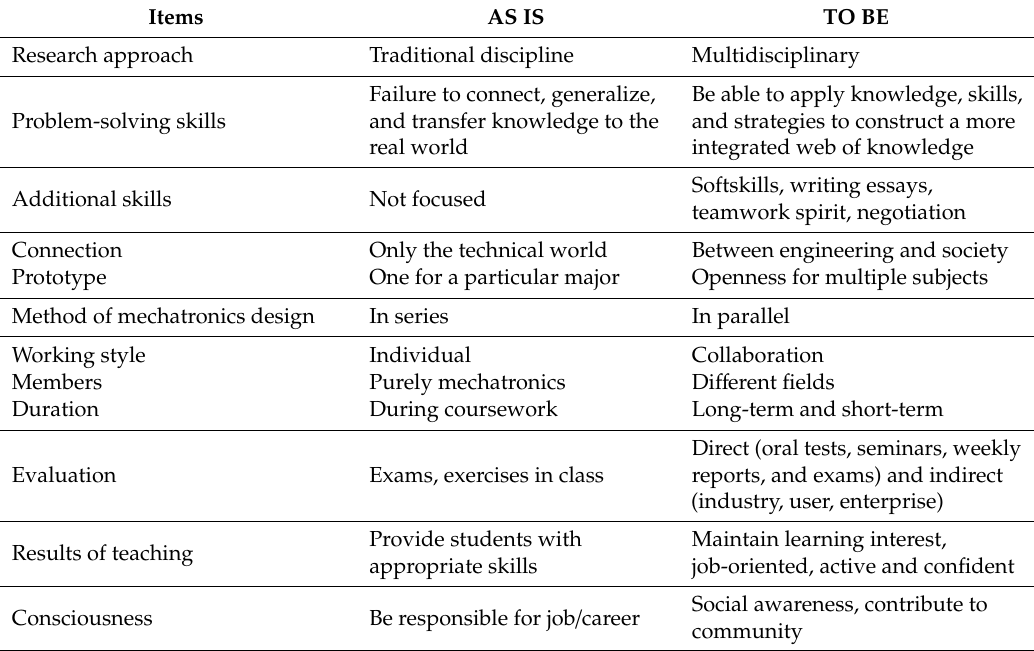
Table 1. Outline of reality and solutions in mechatronics